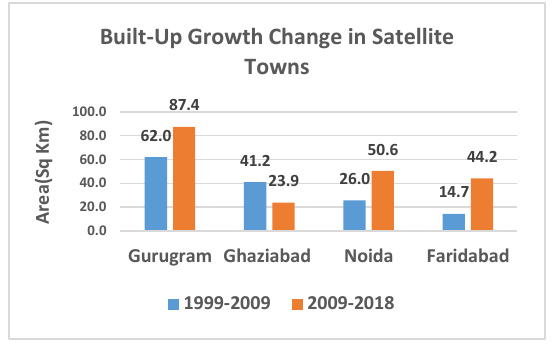
Figure 1. Graph showing growth in Built-up area over years